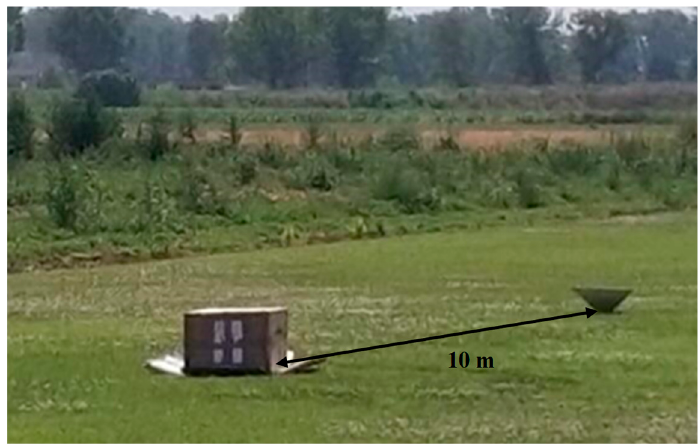
Figure 9. The UAV-borne radar imaging scenario. Table 2. Radar system parameters.